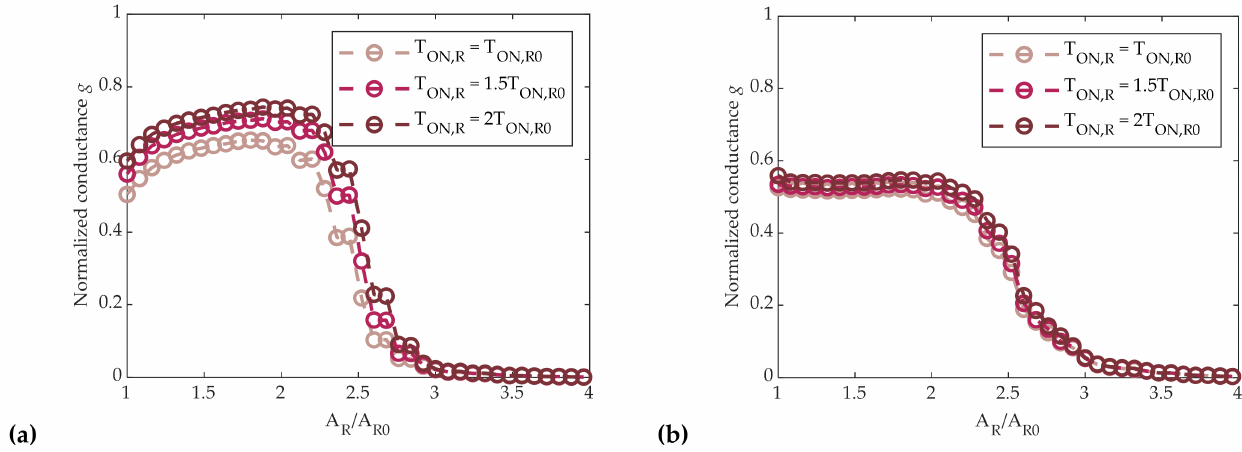
Figure 10. ( a ) RSP programming curves as a function of RESET pulse amplitude, with different T ON,R values. The generic g(A R,i ) represents cells normalized mean conductance after the application of a start SET pulse and a RESET pulse with amplitude A R,i . ( b ) RSC programming curves as a function of RESET pulse amplitude, with different T ON,R values. The generic g(A R,i ) represents cells normalized mean conductance after the application of a start SET pulse and a sequence of RESET pulses with amplitude from A R0 to A R,i .